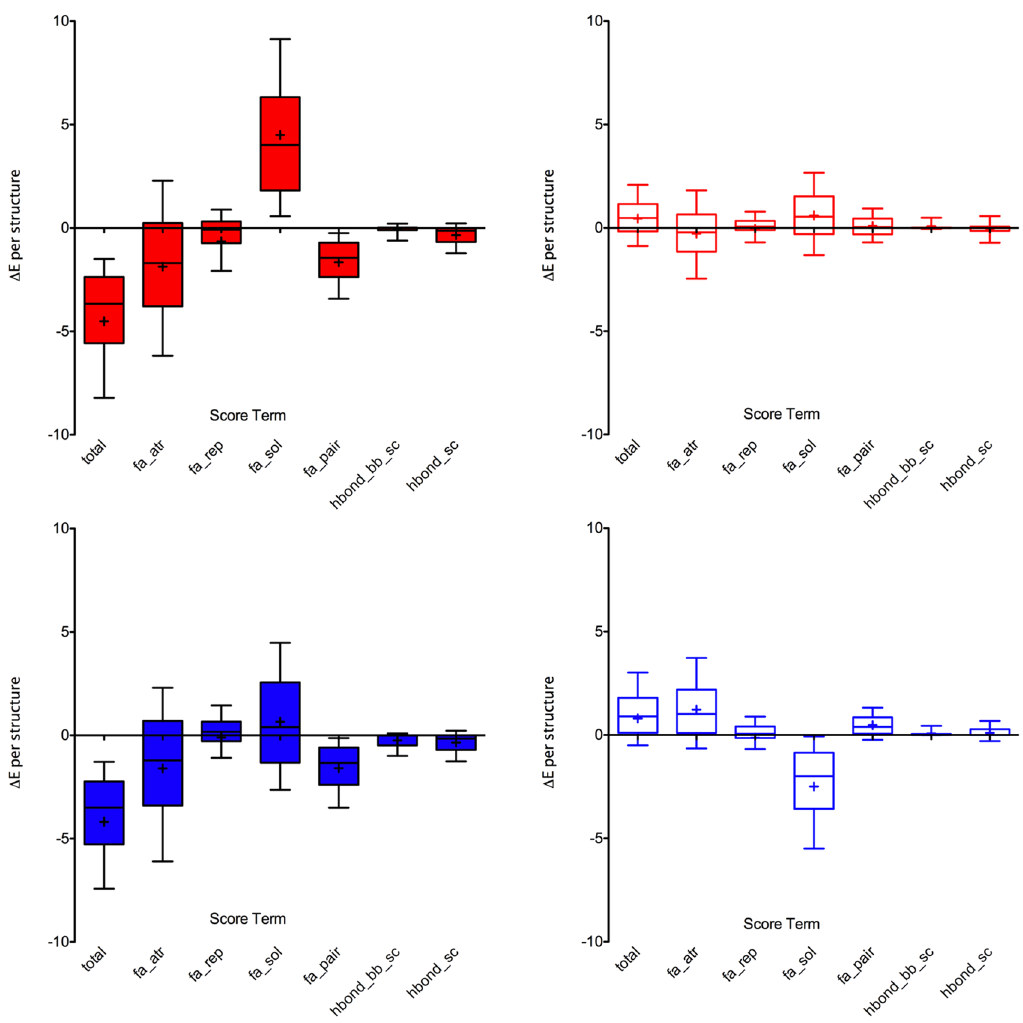
Figure 5. Low-charge variant residue energy changes per structure (600 total) broken down by each weighted score term. Red : negative-charge variants. Blue : positive-charge variants. Solid bars : Rosetta designs. Empty bars : AvNAPSA designs. AvNAPSA mutations have little effect on computed energy, on average (right, empty bars). Rosetta improves total energy primarily through Lennard-Jones attraction (fa_atr), charge complementarity (fa_pair), and reference energy, and a minor improvement results from addition of hydrogen bonds (left, solid bars). Rosetta mutations lead to increases in solvation energy (fa_sol) for negative supercharging. Not all score terms are included because their values cannot change in fixed backbone design (backbone-backbone hydrogen bonds, disulfides, proline closure, omega angle planarity). total: total